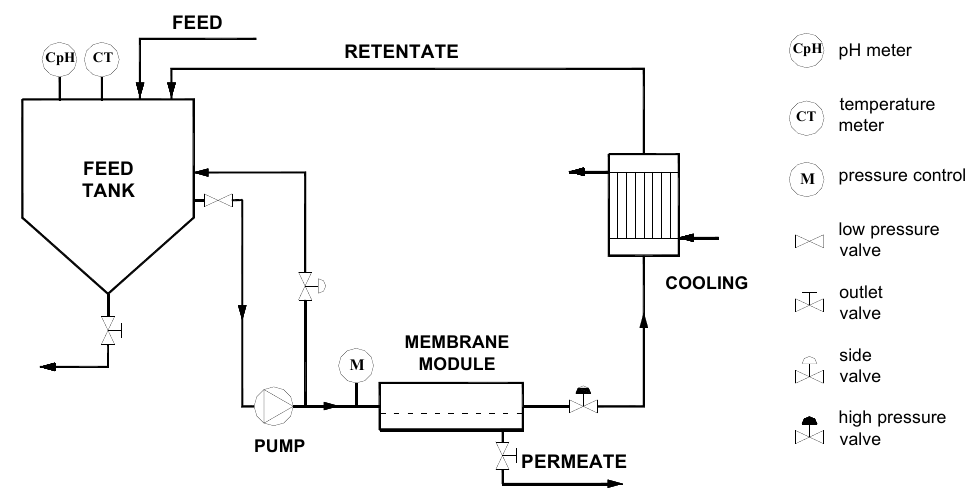
Figure 1. Scheme of experimental